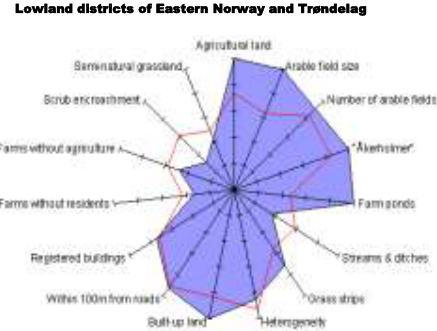
Figure 1. Lowland districts of Eastern Norway and the county Troendelag. The red line is the average of the country and the